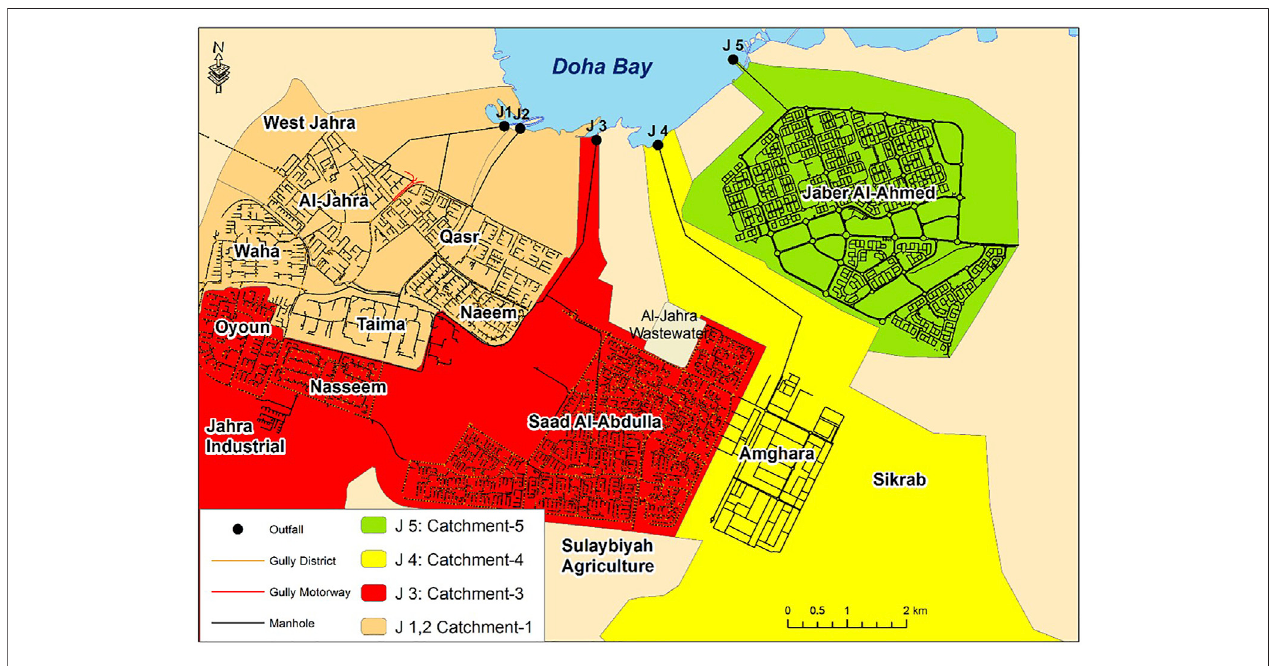
FIGURE 4 | Sewage sources to the outfalls J3, J4, and